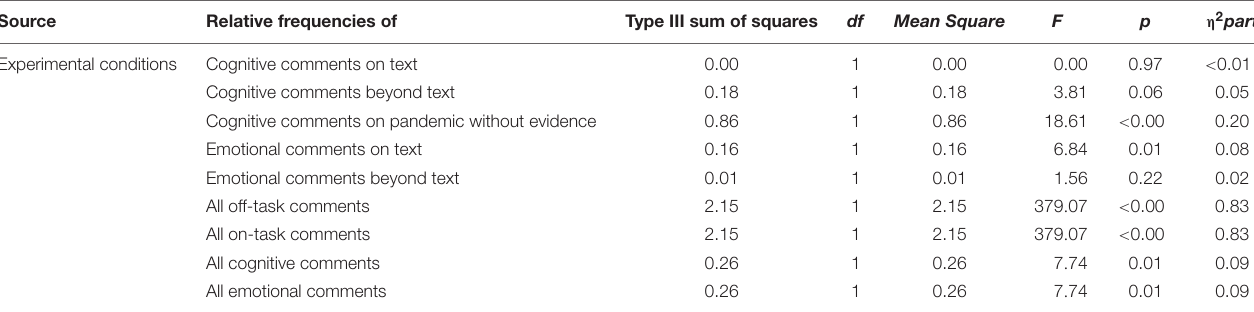
TABLE 6 | Multivariate ANOVA to test for differences between the experimental conditions, regarding the relative frequencies of cognitive and emotional reflection around the engagement with conflicting information and the pandemic in general, as well as between all on-task and all off-task comments. Source Relative frequencies